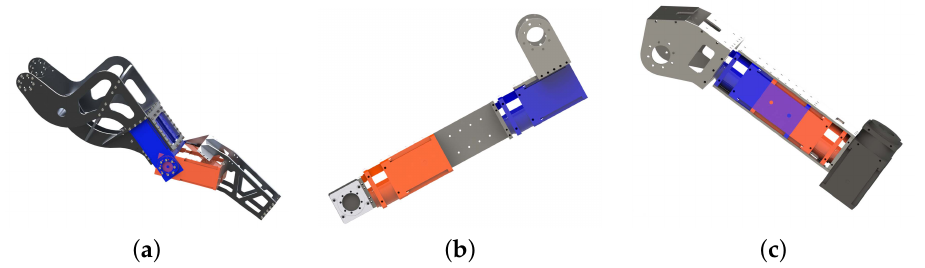
Figure 9. Possible actuator arrangements, blue for JET and orange for bad case: ( a ) Knee actuator arrangements, ( b ) Forearm actuator arrangements, ( c ) Arm actuator arrangements.